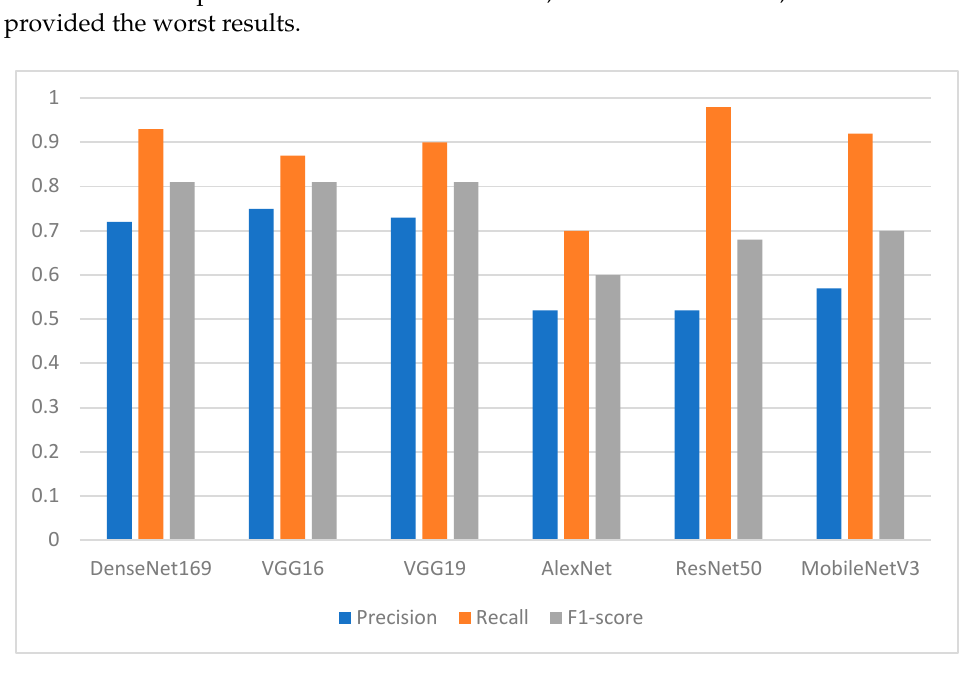
Figure 12. Performance of the models in terms of precision, recall, and F1-score with respect to class 1 (class of missing teeth).